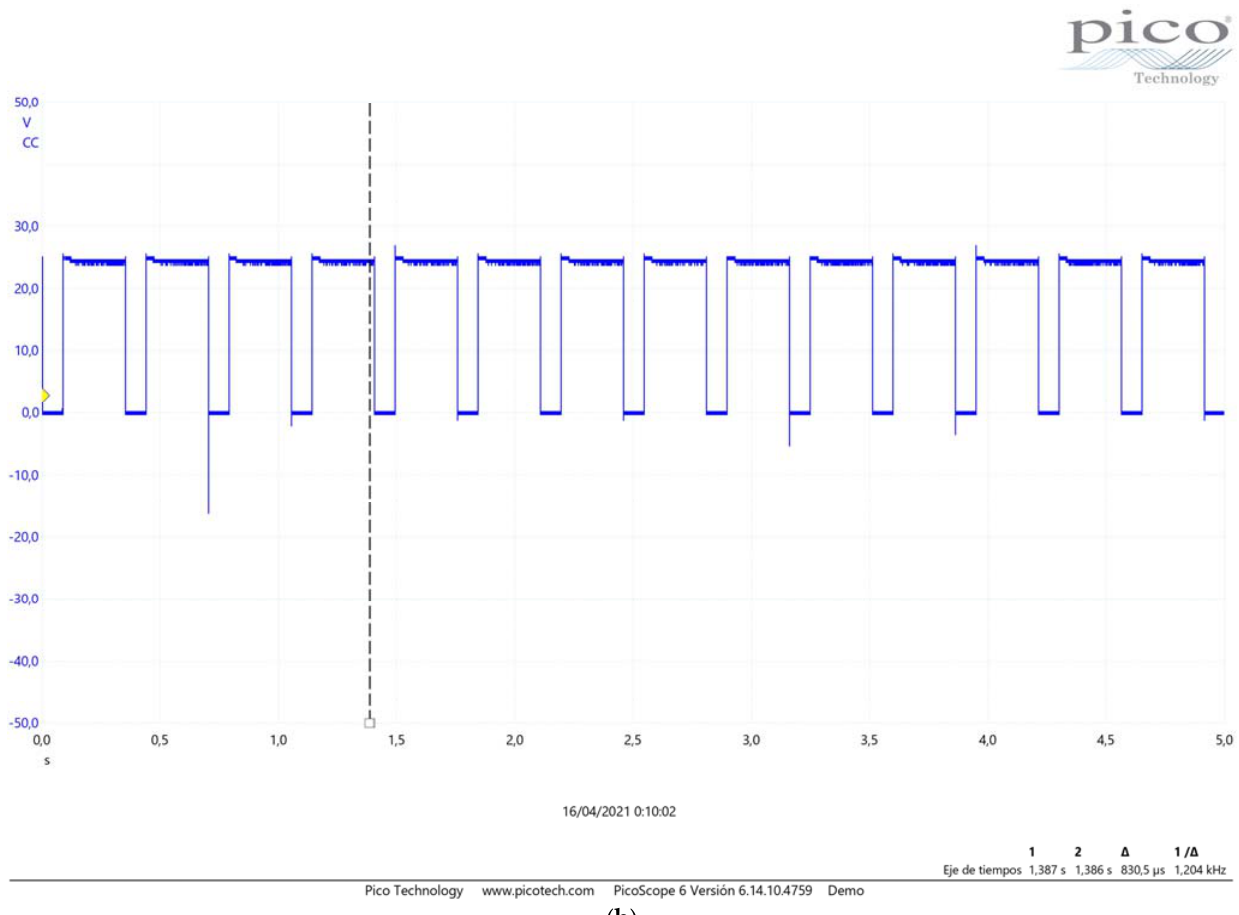
Figure 9. Voltage peaks (Vdc) in reed contact using intermediate relays ( a ), Voltage peaks (Vdc) in reed contact using solid state relays ( b ).